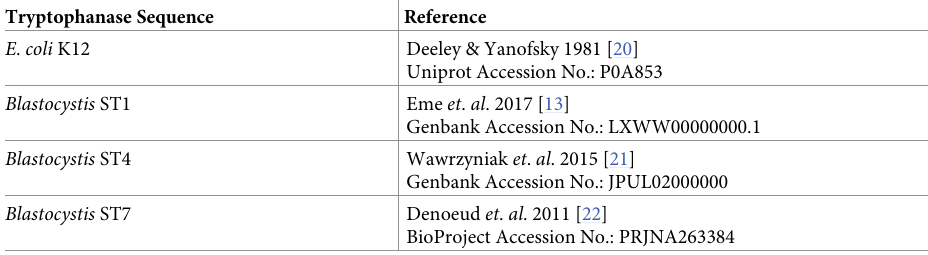
Table 1. Tryptophanase Sequences for Bioinformatic Analysis. Tryptophanase